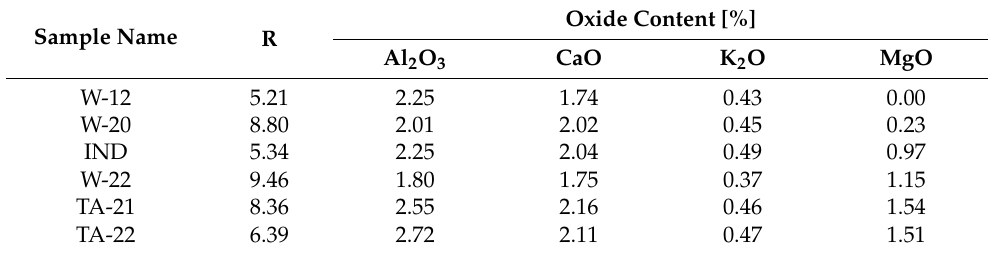
Table 1. Chemical composition and molar ratio Fe 2+ /Fe 3+ (R) of catalyst precursors.